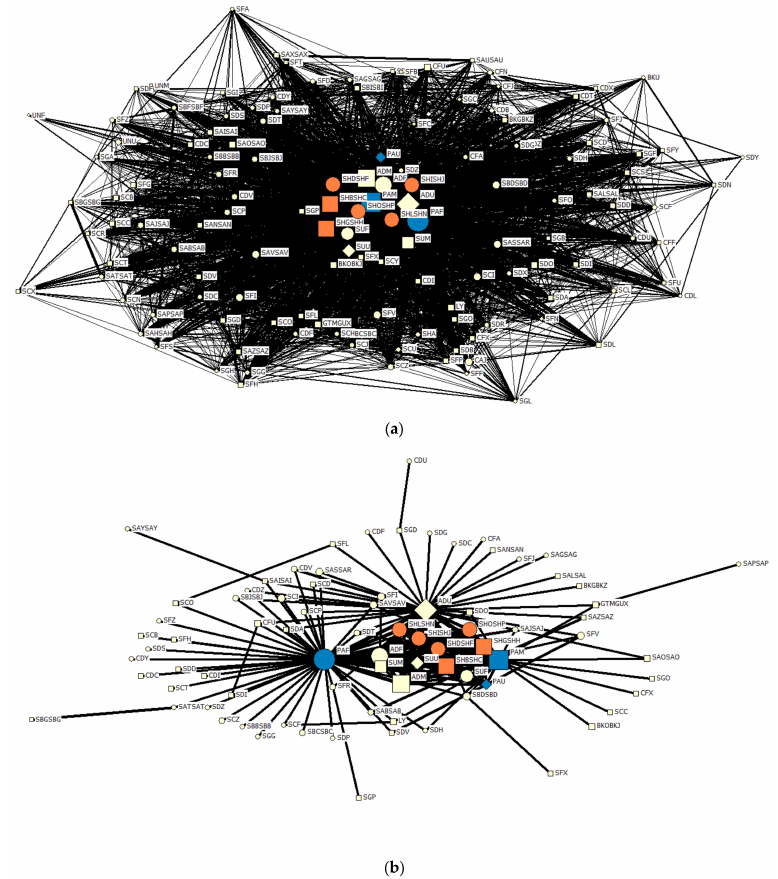
Figure 6. ( a ) General social network of Chilean flamingo chicks from March 2019 to July 2019 with all assoiations and ( b ) weak associations omitted (<.04 association rate). Foster-reared chicks = orange, parent-reared chicks = blue, all other identified individuals = white. Male = square, female = circle, diamond = unknown. Node size reflects the influence of that individual in the social network by means of eigenvector centrality. Ties between nodes are weighted by strength to highlight strength of associations. The network was spring embedded to determine distance between individual nodes. Chicks held a large range of weak and strong associations, forming a diverse